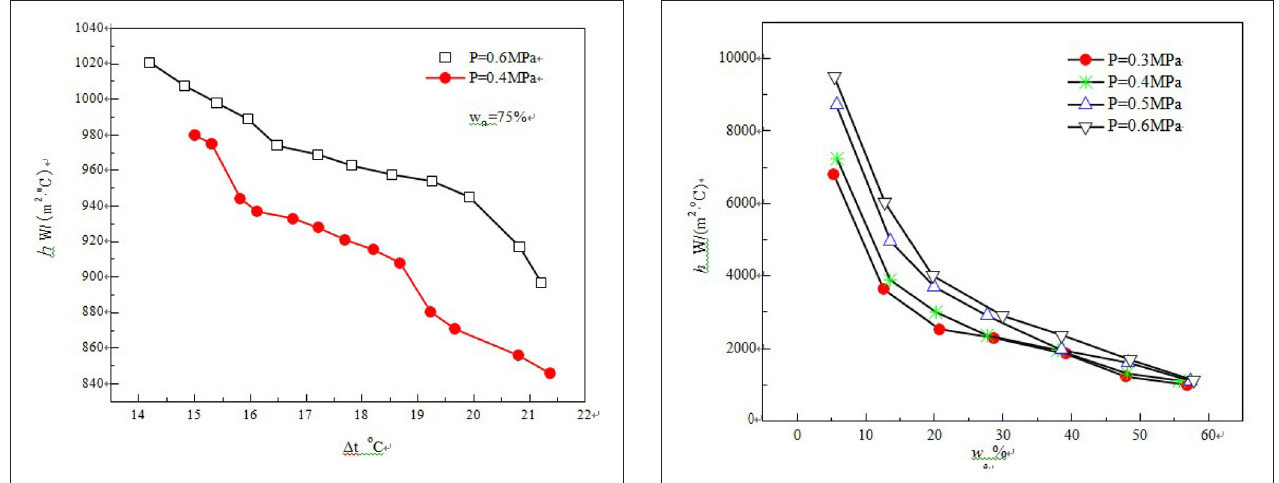
FIGURE 3 | Effect of wall subcooling on the condensation heat transfer coefficient. FIGURE 4 | Change curve of air mass fraction with condensation heat transfer